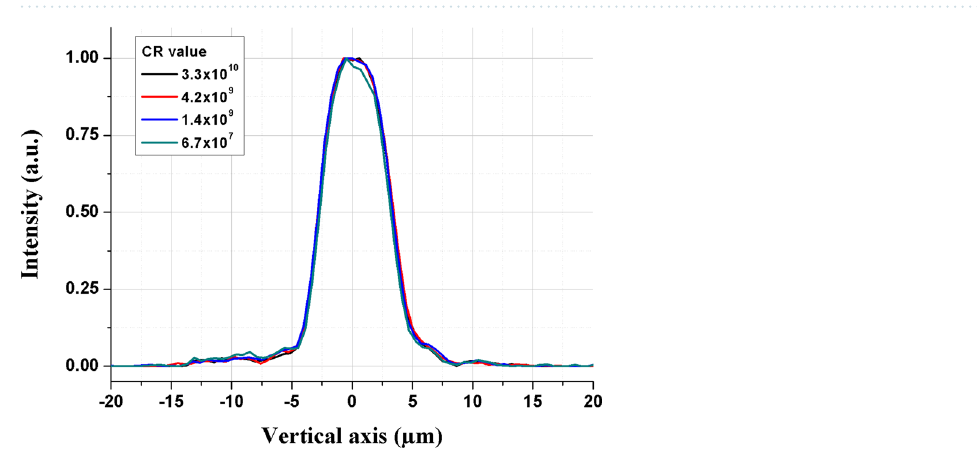
Figure 7. Spatial vertical profile of the laser focal spot for the four temporal contrast values studied. Profiles are CR